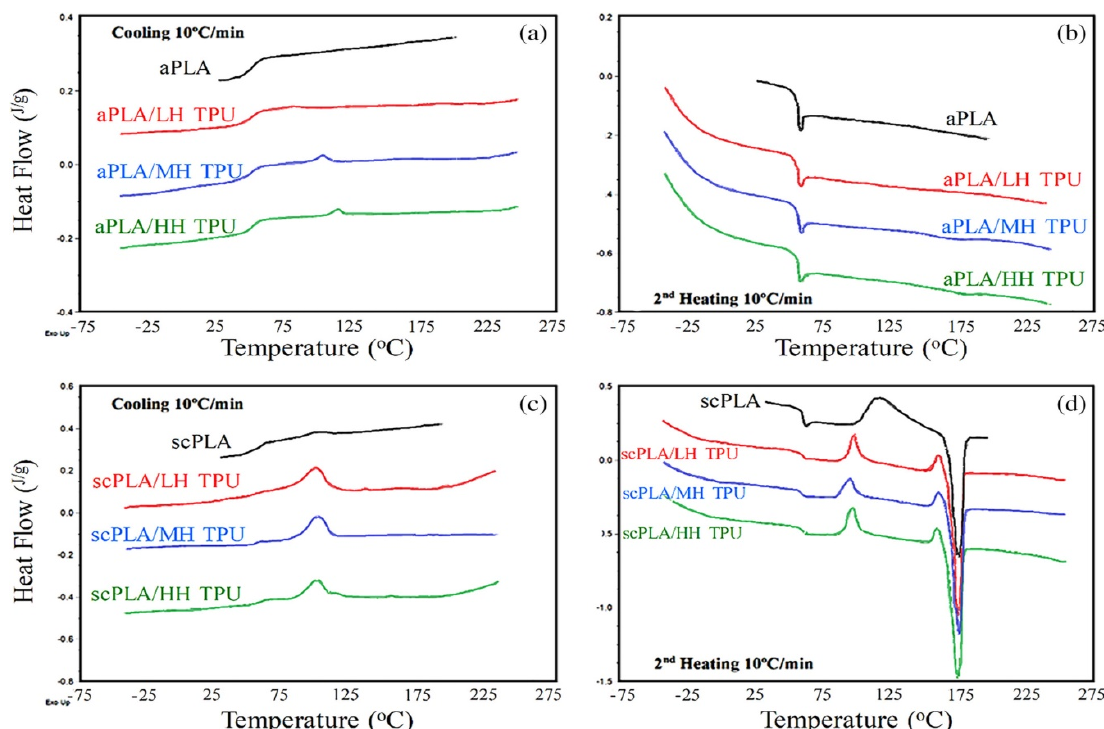
Figure 9. The DSC cooling and second heating thermograms of the ( a , b ) aPLA/TPU and ( c , d ) scPLA/TPU blend systems processes [Reproduced with a copyright permission from Nofar et al. [190].